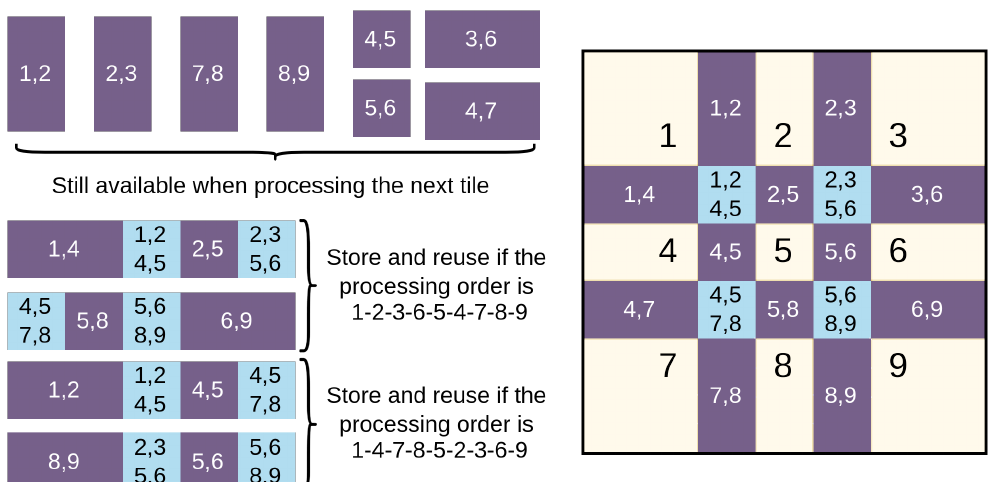
Figure 7. Overlapping tiles that require buffering. Only one entire block out of the four marked for reuse has to be stored to allow for zero recomputation